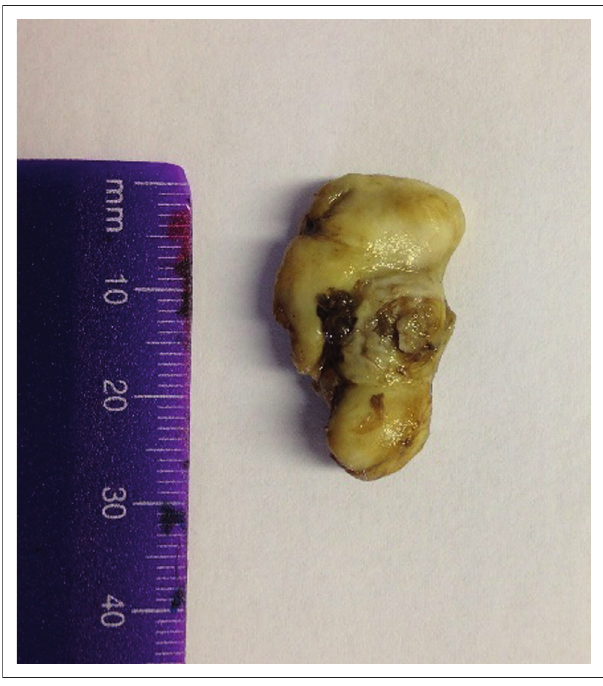
FIGURE 2: The keratoma that was removed from the right hind hoof of a four- year-old Thoroughbred gelding Figure 1, taken 5 days after the procedure, shows the location of the keratoma.